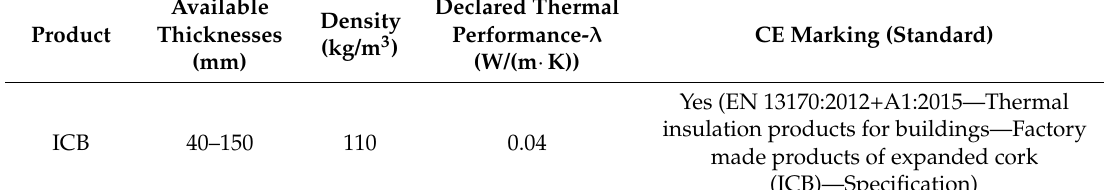
Figure 2. ICB glued to gypsum plasterboard in an Internal TICS (ITICS) [10]. Table 1. Main technical characteristics of ICB studied in this paper.